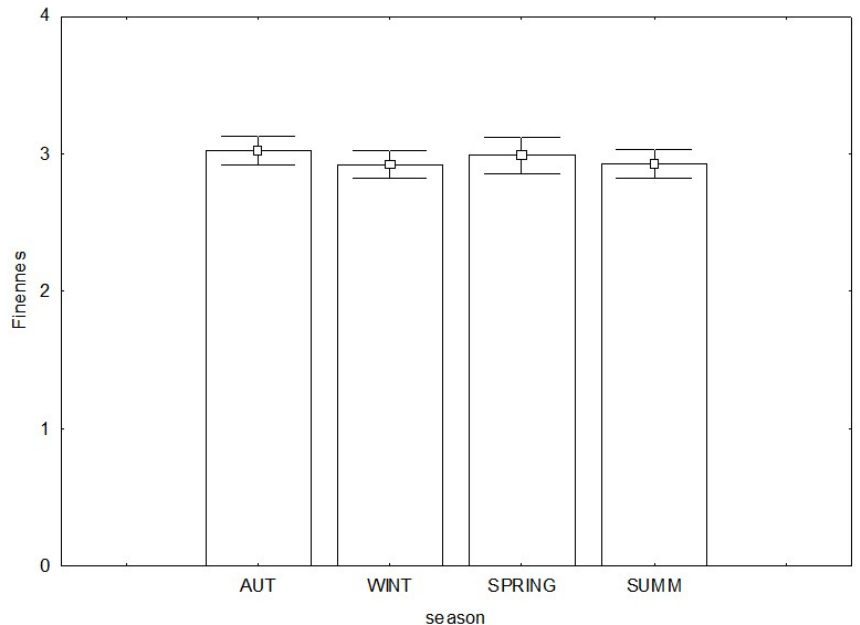
Figure 3. Fineness of queen scallops ( n = 80), sampled in four seasons: Autumn (AUT), Winter (WINT), Spring (SPRING) and Summer (SUMM).